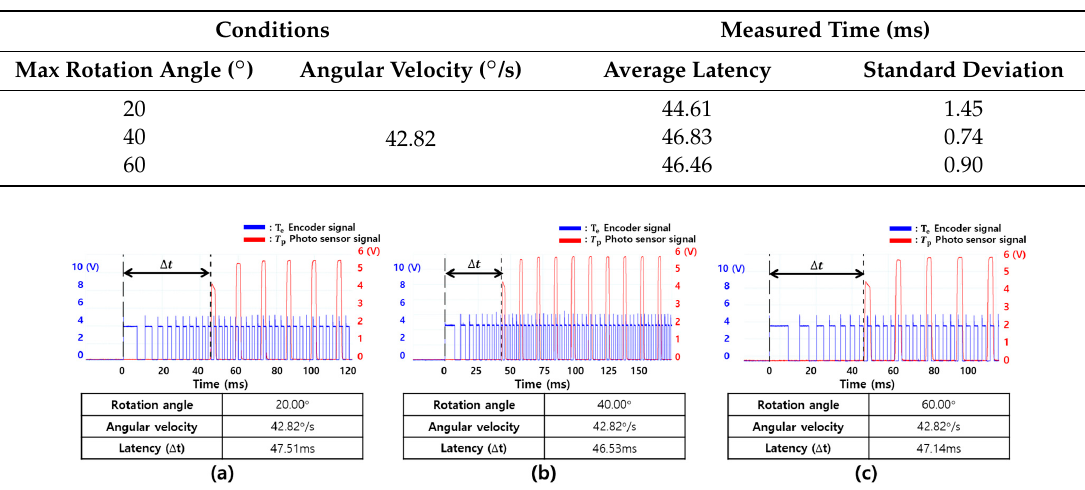
Figure 14. Latency measurement results when the yaw rotation angle was changed: ( a ) 20 ◦ , ( b ) 40 ◦ , and ( c ) 60 ◦ .